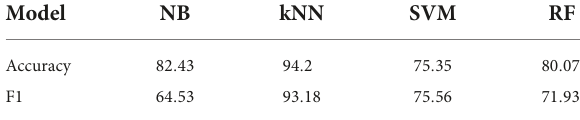
TABLE 4 Accuracy of classification